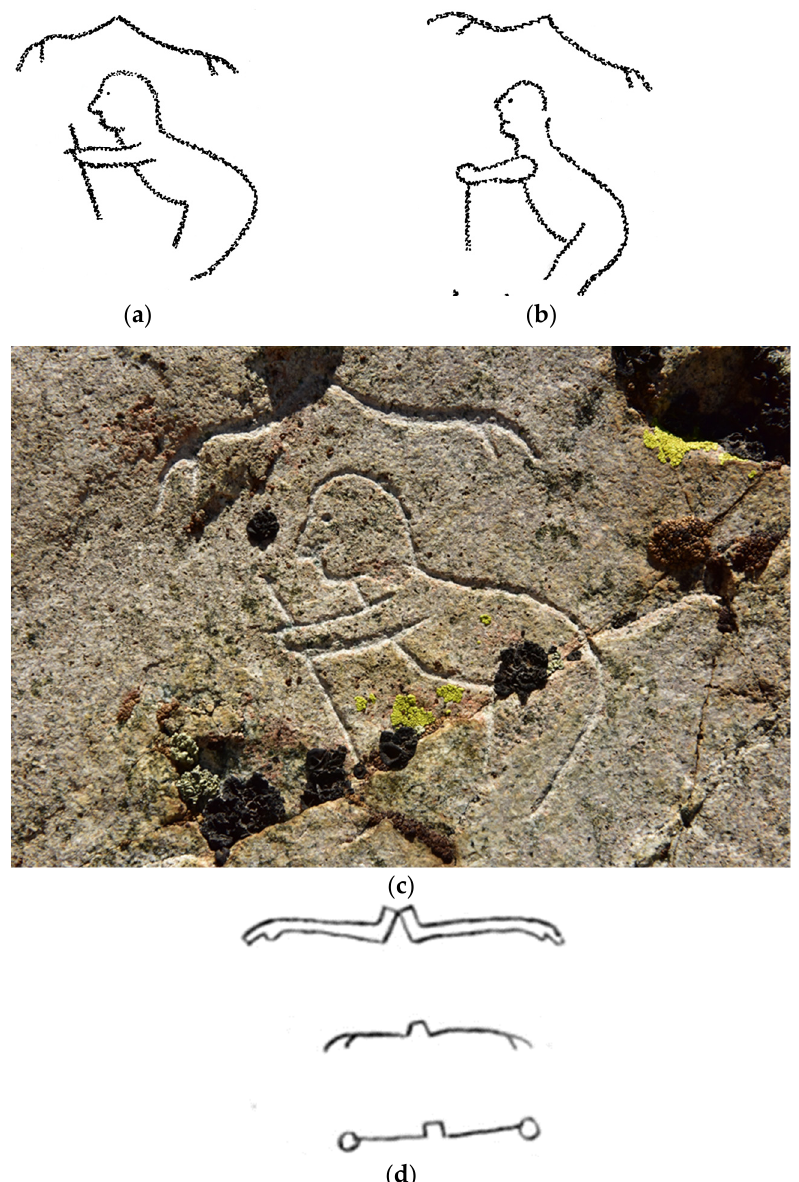
Figure 26. ( a ) “Not old man” (e.g., young man). Western Message Petroglyph (Virginia City, NV). ( b ) “Not old man” (e.g., young man). Western Message Petroglyph (Tonopah, NV). ( c ) Detail.